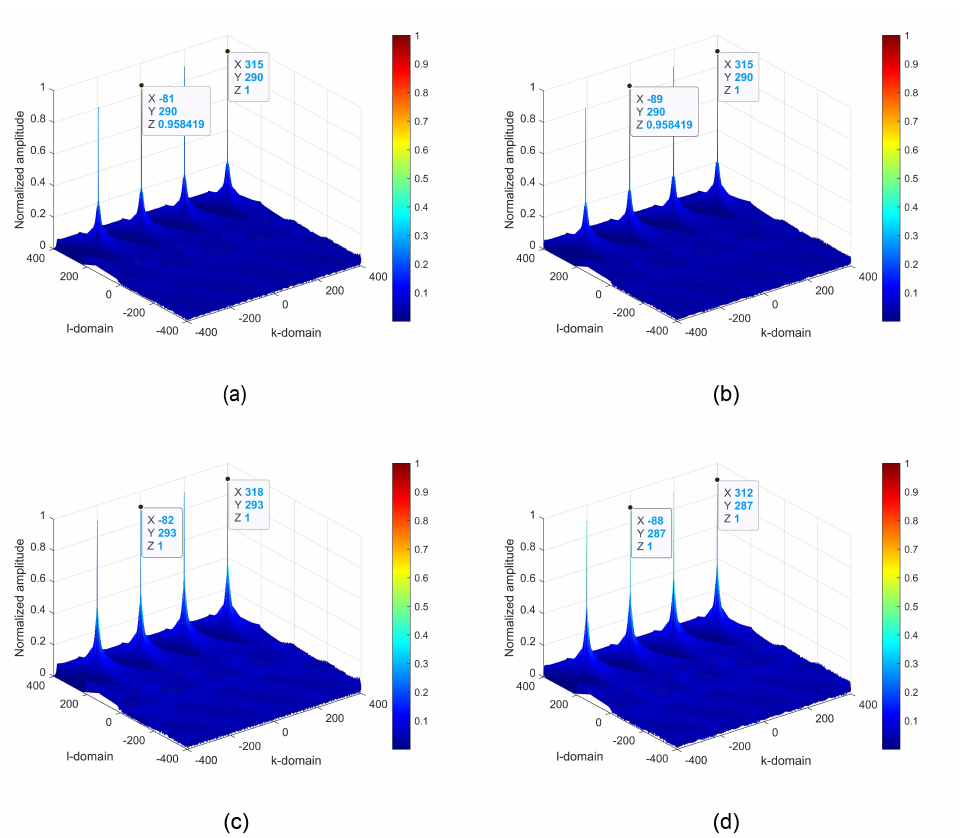
Figure 3. Simulation results of Example 3. ( a ) The result of SZDCFT ( ψ 1 = 1.01). ( b ) The result of SZDCFT ( ψ 2 = 0.99). ( c ) The result of ZDCFT ( ψ 1 = 1.01). ( d ) The result of ZDCFT ( ψ 2 =